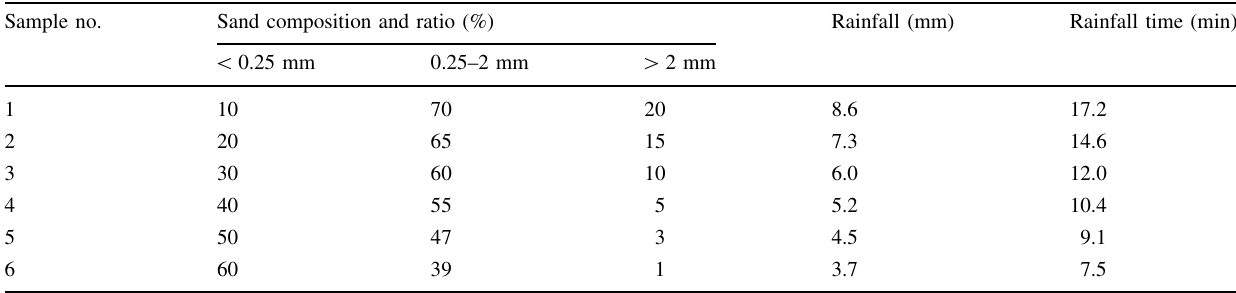
Table 4 Effect of rainfall amount and duration thresholds on the grain-size composition of water–sand flows Sample no.